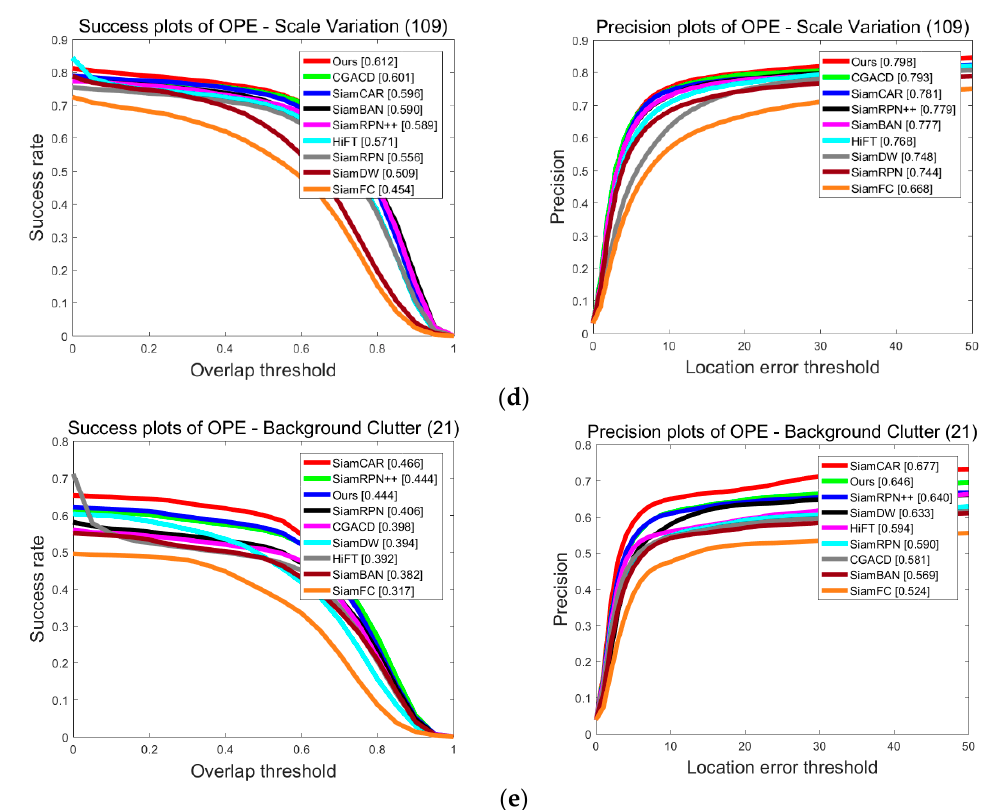
Figure 10. Attribute-based experiment results corresponding to 5 scenes on UAV123, including ( a ) full occlusion; ( b ) low resolution; ( c ) partial occlusion; ( d ) scaled variation; ( e ) background clutter.